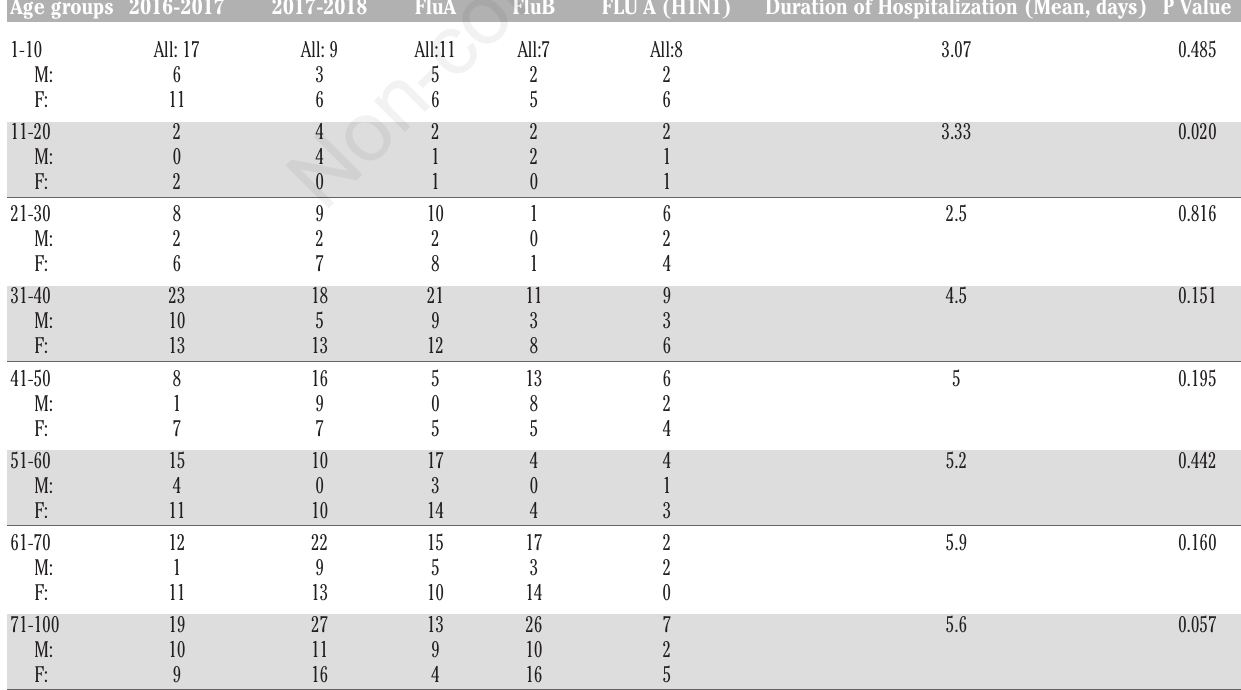
Table 2. Rate of Influenza diagnosis and duration of hospitalizations according to different age